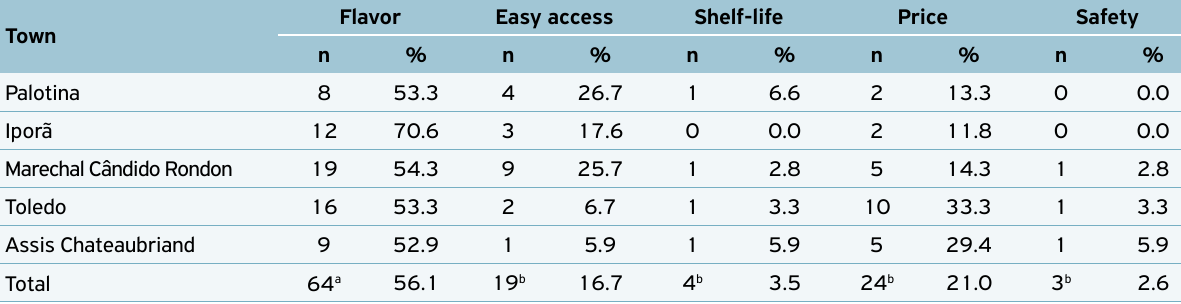
Table 2. Reasons for the preference for uninspected raw milk consumption (n = 114) in each town. Town